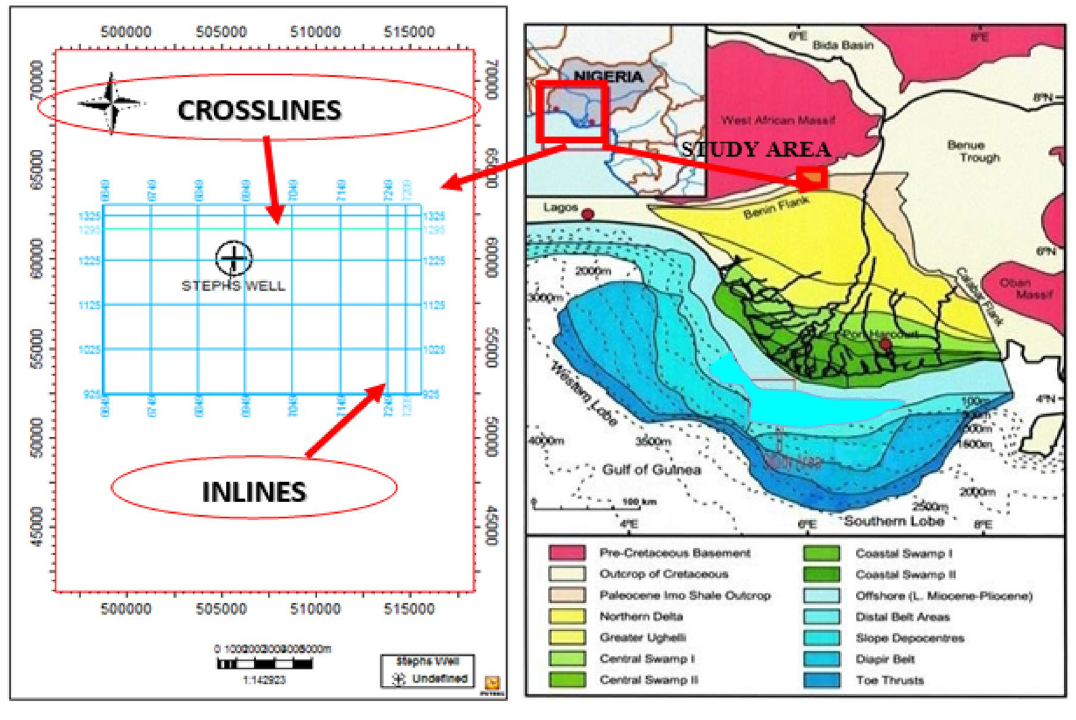
Fig. 2 Location and base map of the study area